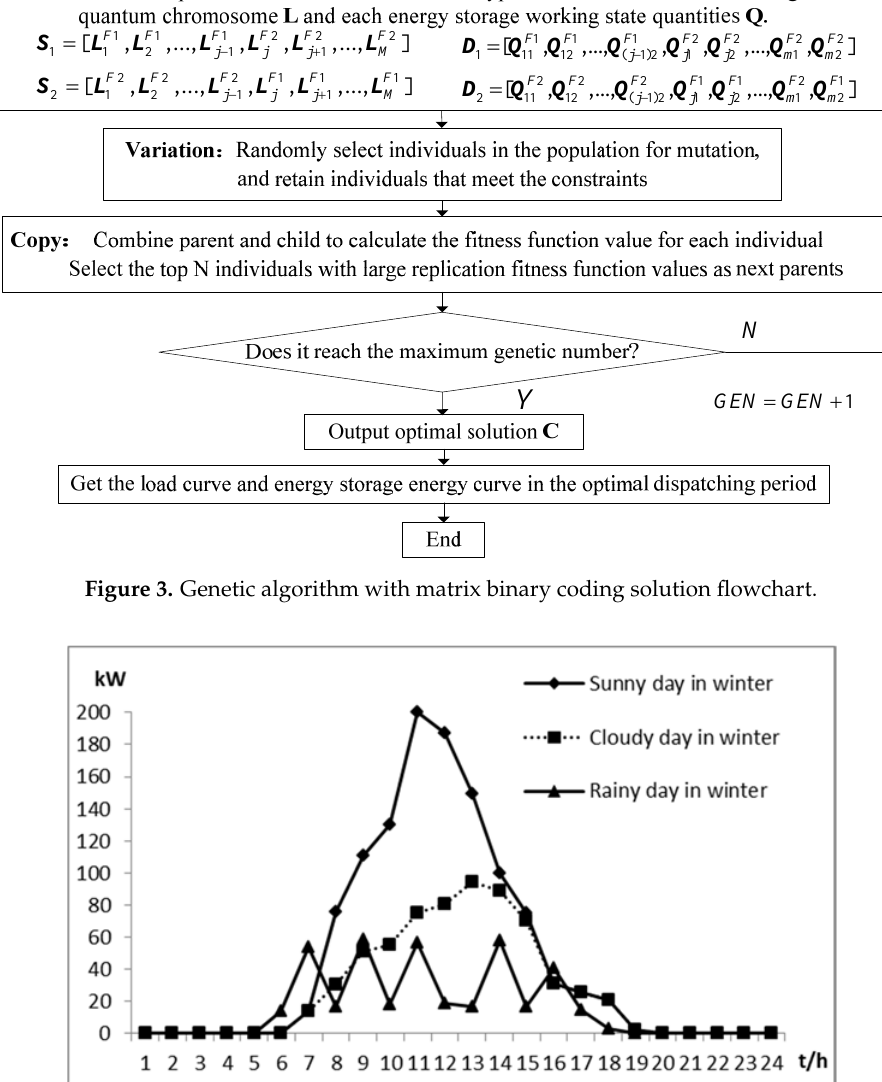
Figure 5. Comparison curve of loads before and after optimization on a sunny winter day.